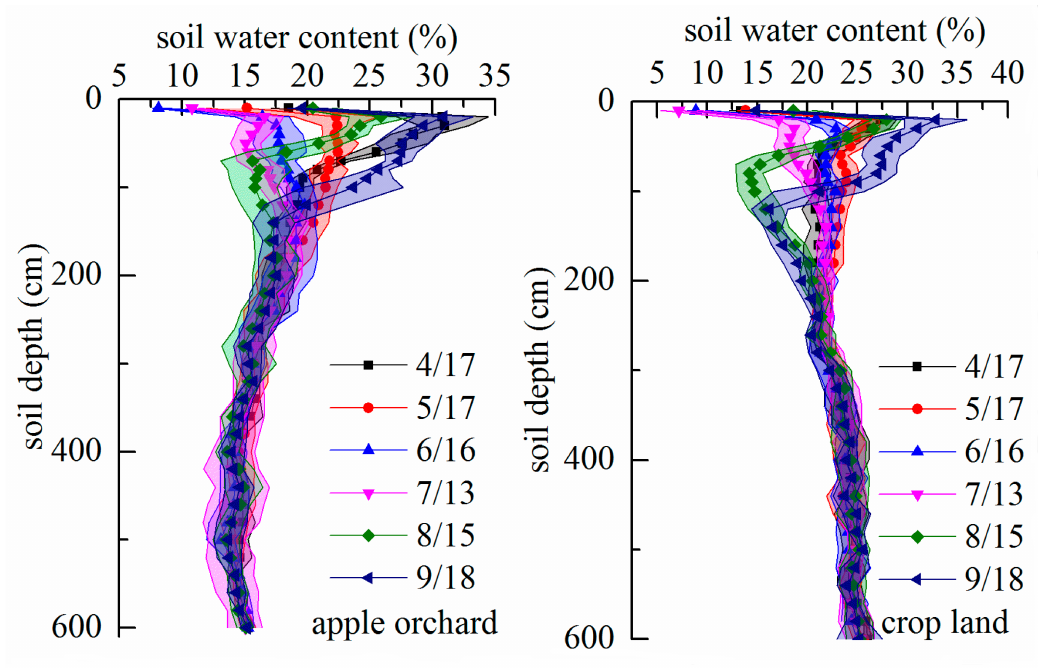
Figure 4. The seasonal variations in soil moisture for different land use types in 2014. The legend in the figure represents the date on which the soil moisture content is